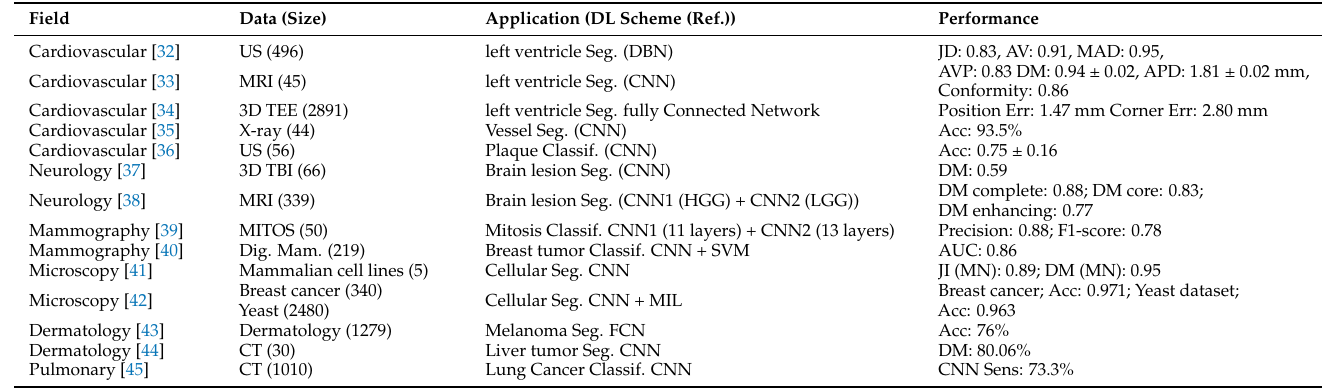
Table 1. Applications of deep learning (Segmentation (Seg.) and Classification